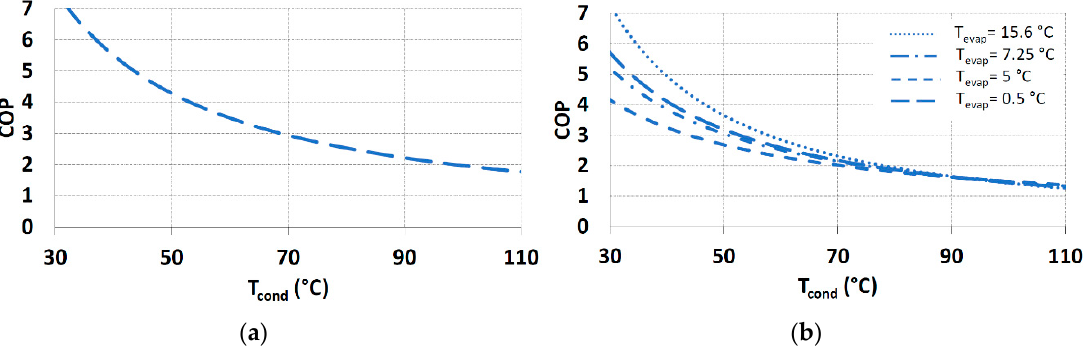
Figure 9. Coefficient of performance (COP) corresponding to ( a ) geothermal and ( b ) air heat pump against hot source temperature ( T cond